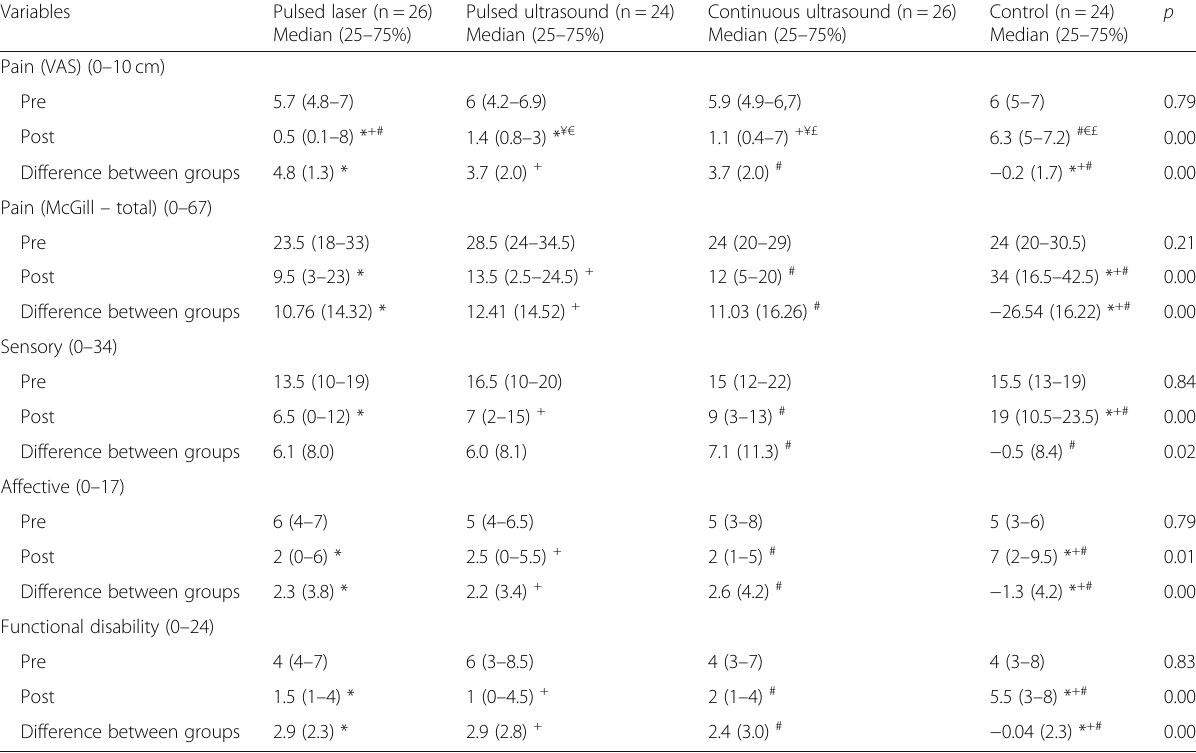
Table 2 Comparison of the treated groups pre- and post-treatment and the control group for the evaluation and re-evaluation